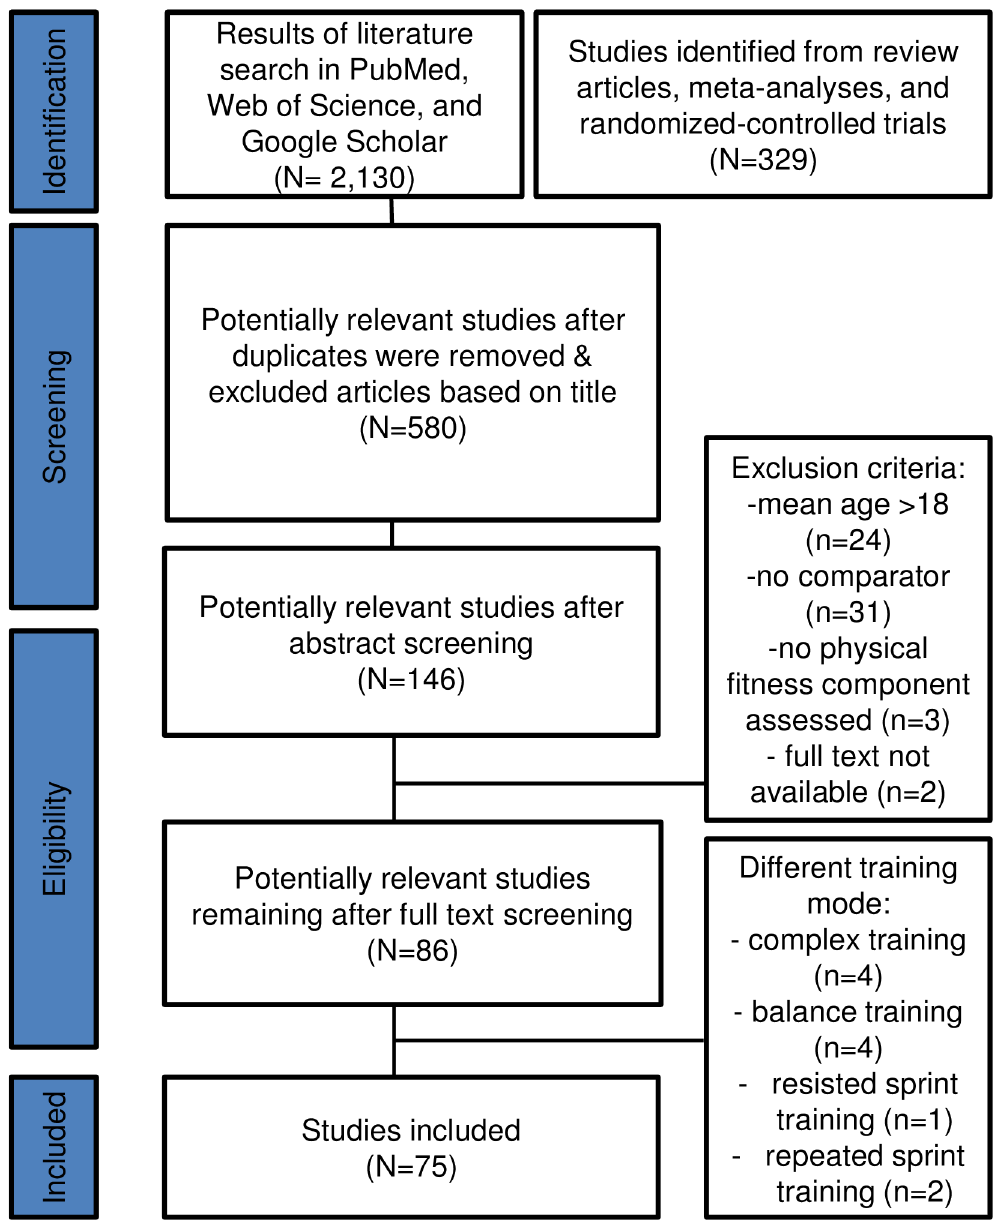
Fig 1. Flow chart illustrating the phases of the literature search and study